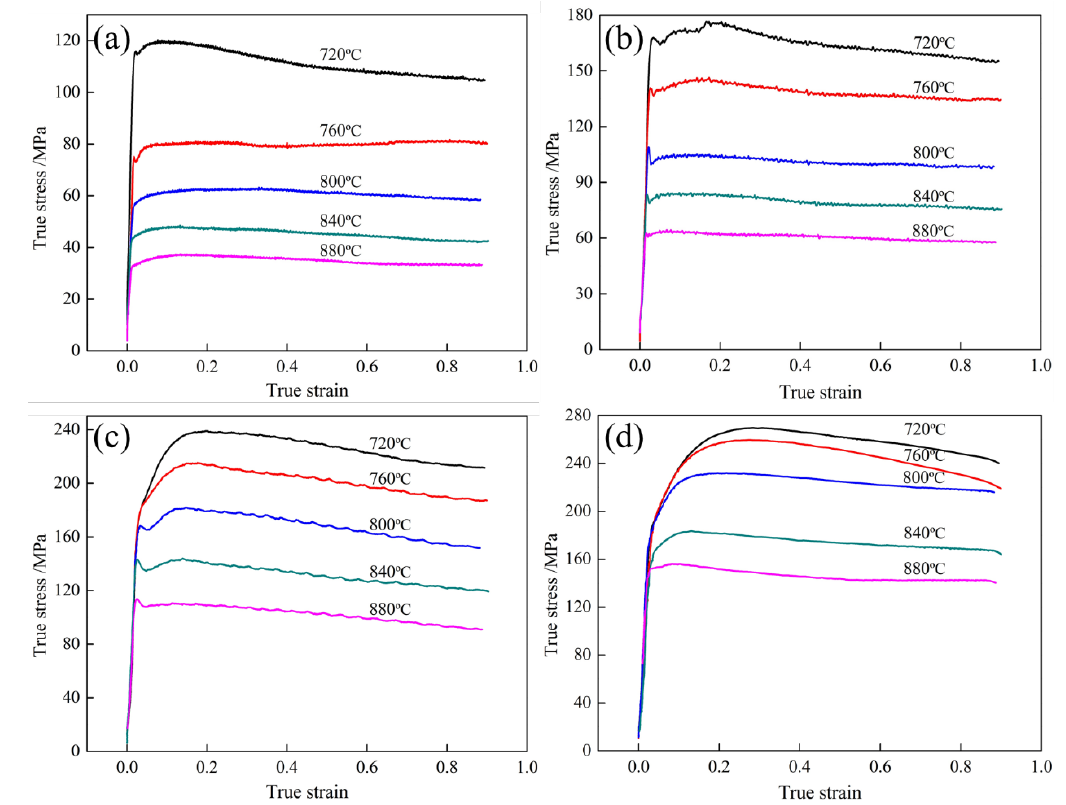
Figure 2. True stress–true strain curves of the Cu-Ni-Sn-Zn-Mn alloy at a strain rate of ( a ) 0.001 s −1 , ( b ) 0.01 s −1 , ( c ) 0.1 s −1 , and ( d ) 1 s −1 .